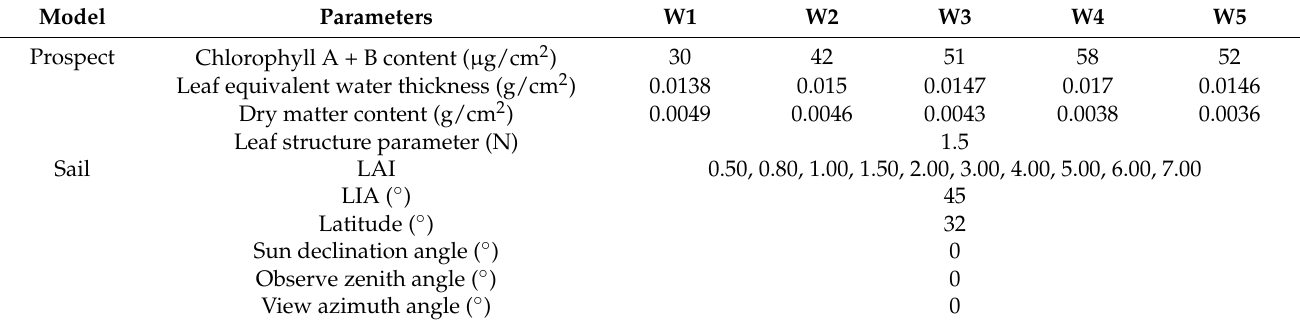
Figure 5. Leaf and soil spectral reflectance of summer maize under continuous water stresses. Table 3. The input parameters of Prospect and Sail models when simulating the impact of LAI on the leaf-canopy scale effect.